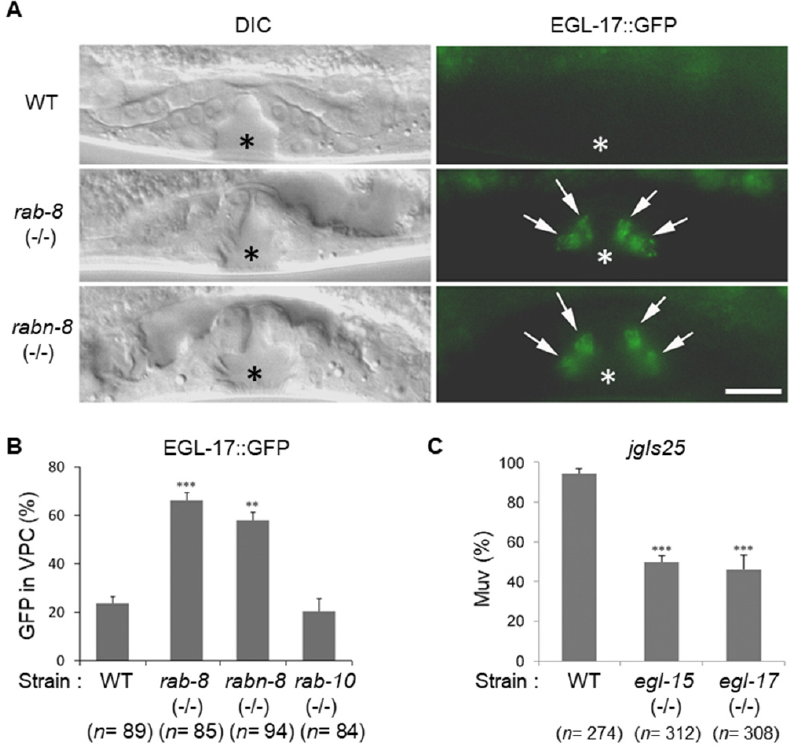
Figure 5. Function of RAB-8 and RABN-8 in EGL-17::GFP secretion. ( A ) EGL-17::GFP expression in the vulval region of either WT, rab-8 mutant, or rabn-8 mutant worms were observed. Arrows indicate EGL-17::GFP protein expressed in VPC daughter cells. The green signal in the intestine is autofluorescence of gut granules. Asterisks indicate vulval invagination. Scale bar = 10 µ m. ( B ) EGL-17::GFP-positive worms in each group were counted. Error bar = SEM. ( C ) The jgIs25 strain was crossed with the FGFR or FGF mutants ( egl-15 or egl-17 respectively), and worms with Muv were counted. Error bar = SEM. (** p < 0.01, *** p < 0.001 versus WT). These experiments were performed three times with comparable